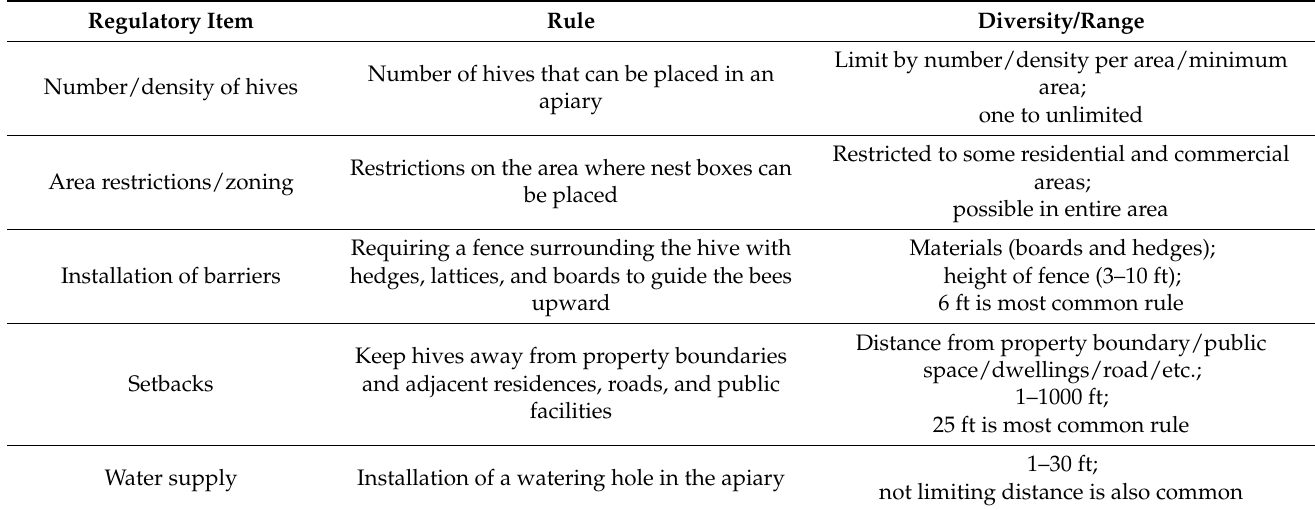
Table 5. Regulatory items for urban